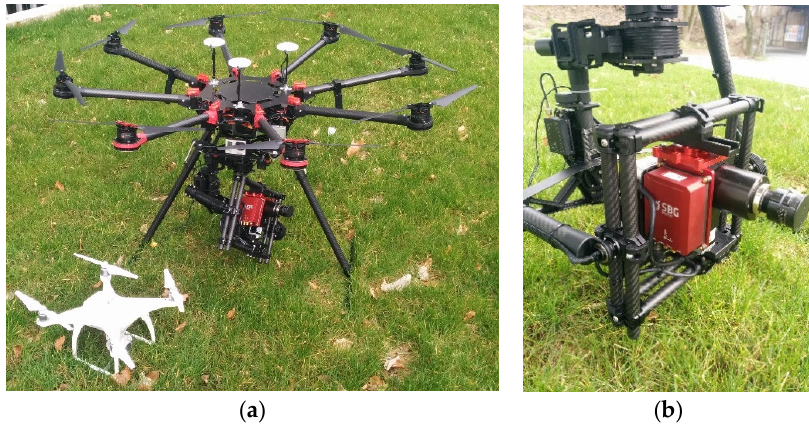
Figure 2. Octocopter with mounted camera ( a ) and close up of the three-axis gimbal with camera system and inertial measurement unit (IMU) ( b ).